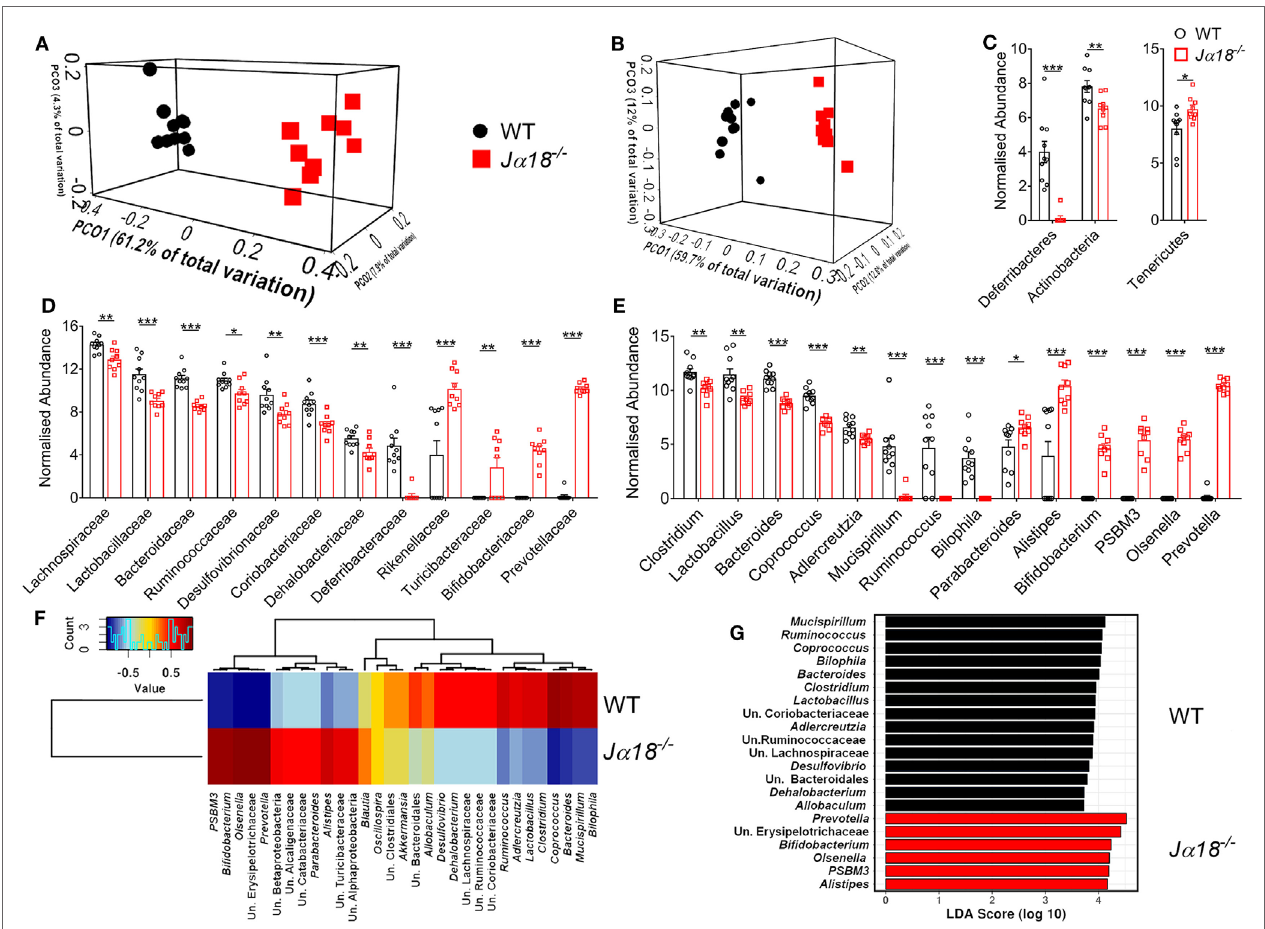
FigUre 2 | The effect of microbiota differences between wild type (WT) ( n = 10) and J α 18 − / − ( n = 9) mice. Both (a) unweighted and (B) weighted UniFrac analysis distance shown as Principal Coordinates Analysis plot, demonstrate strong and significant (both ADONIS p < 0.001) difference between the WT and J α 18 − / − mice communities. The noticeable differences [ t test on Cumulative Sum Scaling (CSS) log 2 transformed, CSS normalized data, and FDR corrected p < 0.05] were evident at all taxonomic levels, including a (c) phylum, (D) family, and (e) genus. (F) Pearson-based genus correlation heatmap and (g) LEfSe analysis (black bar: WT, red bar: J α 18 − / − mice) show distinctive genus preference by each WT and J α 18 − / − mice microbial communities. Significance is represented by * p < 0.05, ** p < 0.01, *** p < 0.001. These data were obtained from one experiment (two independent cages/group).